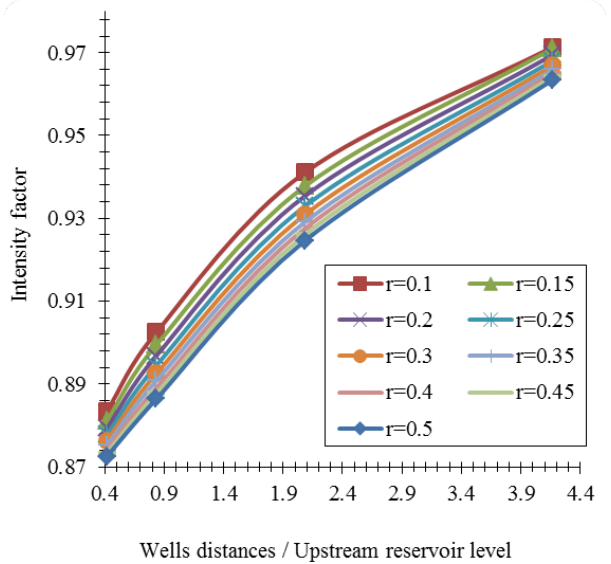
Fig. 6. Effect of various well diameters on uplift pressure when upstream reservoir level is 12 m.